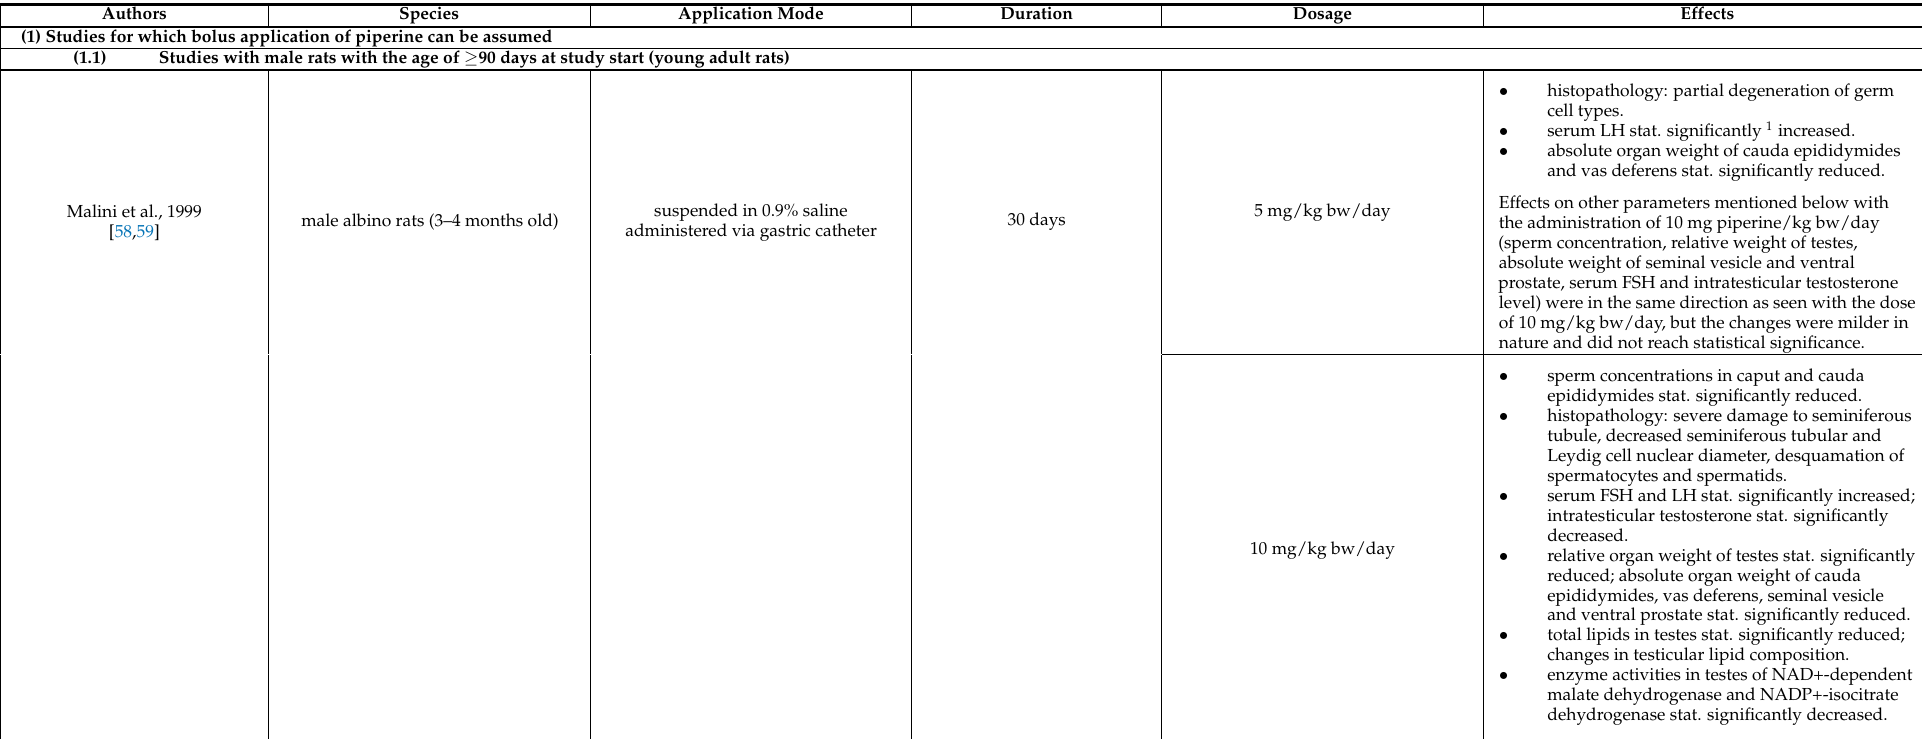
Table 1. Paternal reproductive effects of piperine observed in animal